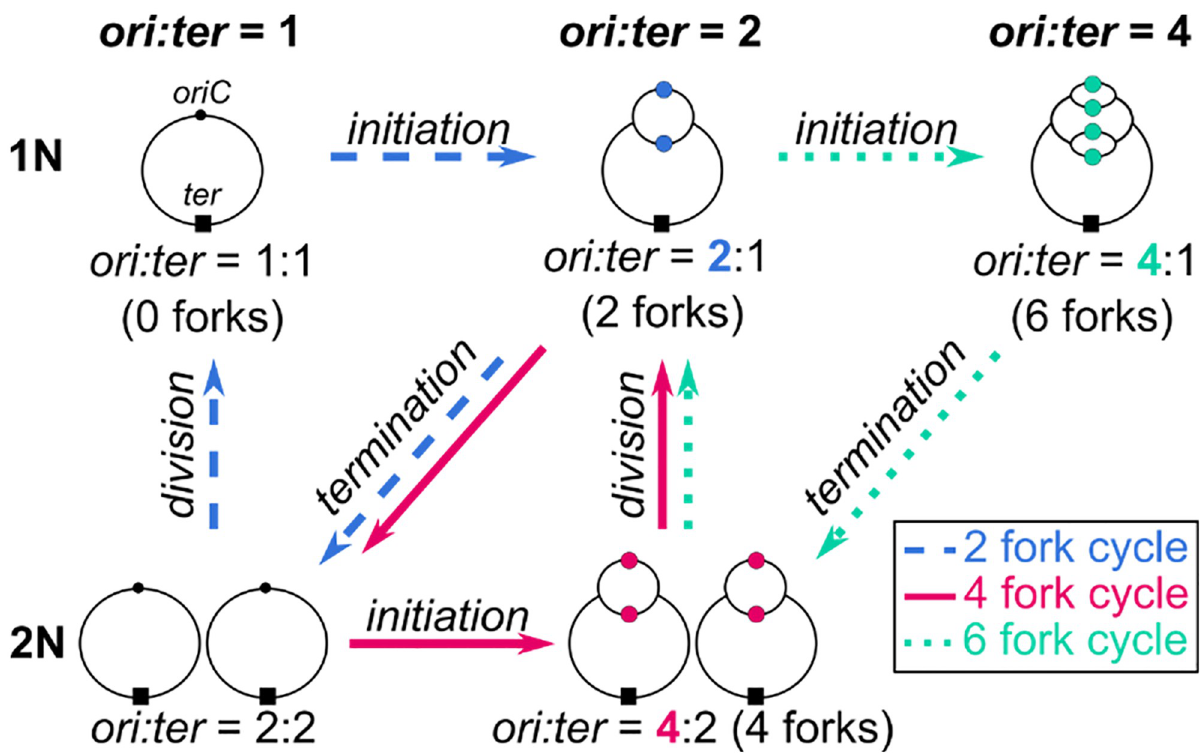
Fig 4. Flow chart depicting the possible replication cycles depending on the order of initiation, termination, and division events. N represents the number of chromosome copies present in the cell and is equal to the number of termini ( ter , & ). The 2-fork cycle (blue) forms 2 forks upon initiation at oriC , ● , then replication is completed leaving 0 forks. The 4-fork cycle (magenta) progresses from 4 forks at initiation to 2 forks after division to termination. The 6-fork cycle (teal) progresses from 6 forks at initiation to 4 forks after termination of previous replication to 2 forks after division to 6 forks after new round of initiation. Further configurations with 8 forks or more are relevant only at growth rates faster than available in this dataset.